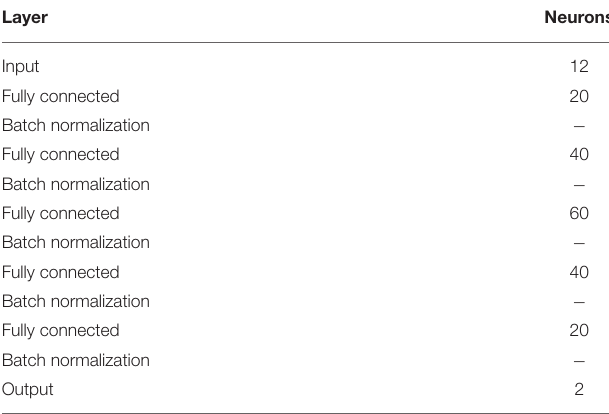
TABLE 3 | Basic architecture of the neural network used for the classification